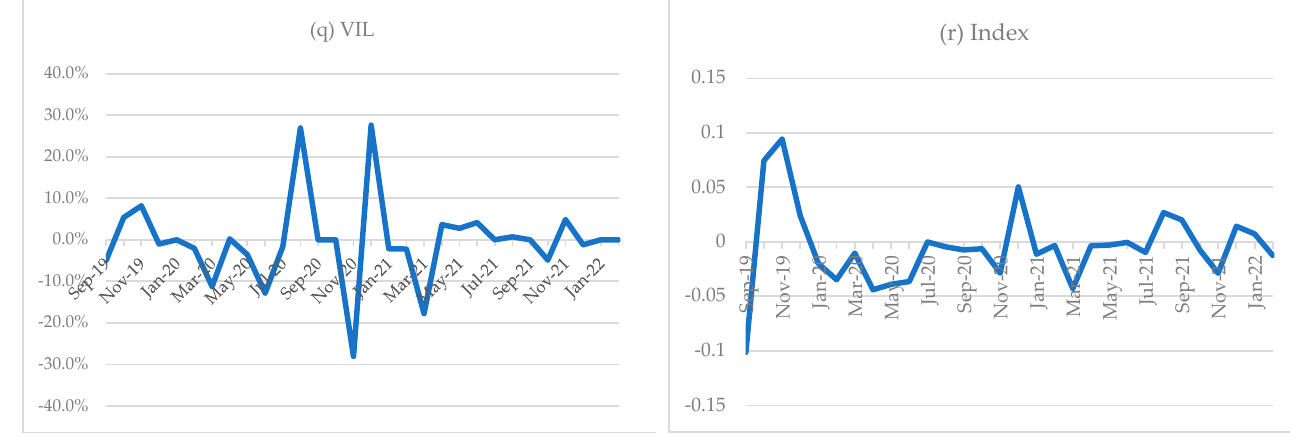
Figure 5. ( a – r ) Monthly Returns (Percentage): SEP-2019 to FEB-2022. Source: Authors’ calculation based on the data from the SPX website.